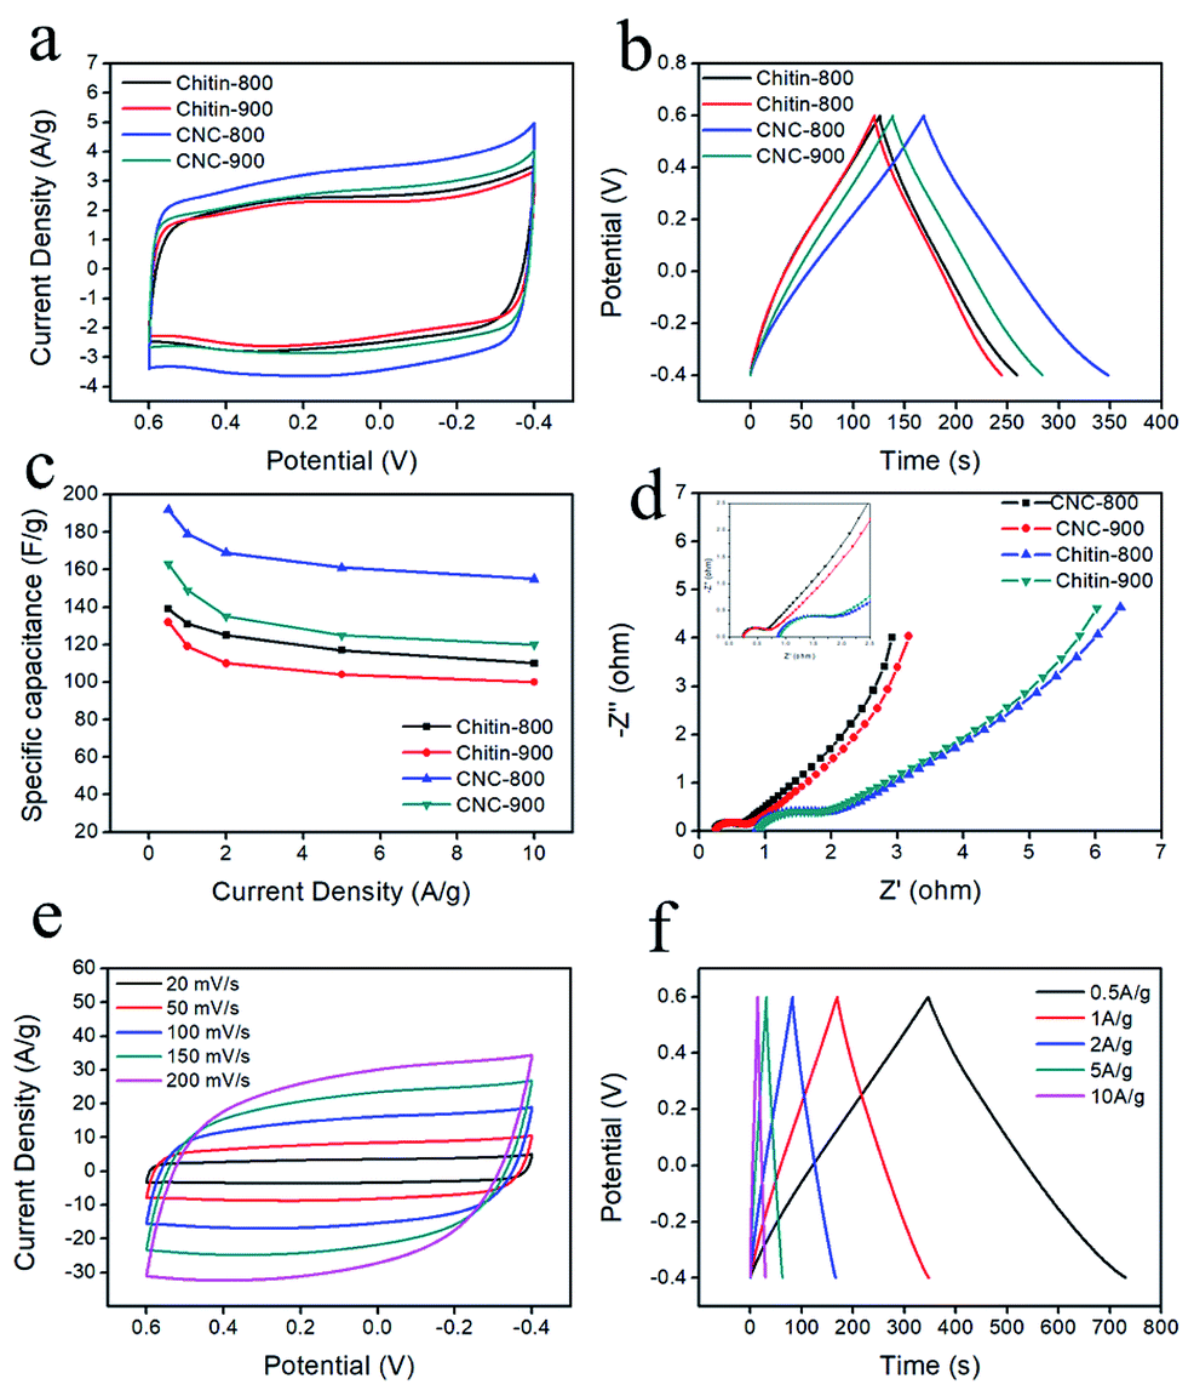
Figure 17. ( a ) CV curves of carbons at a scan rate of 20 mV/s; galvanostatic charge–discharge curves ( b ) at a current density of 1 A/g; specific capacitance versus current density ( c ); EIS analysis ( d ); CV curves ( e ) of CNC-800 at different scan rates in 1 M H 2 SO 4 aqueous solution; galvanostatic charge– discharge curves ( f ) at different current densities. Adapted from reference [96]. This article is an